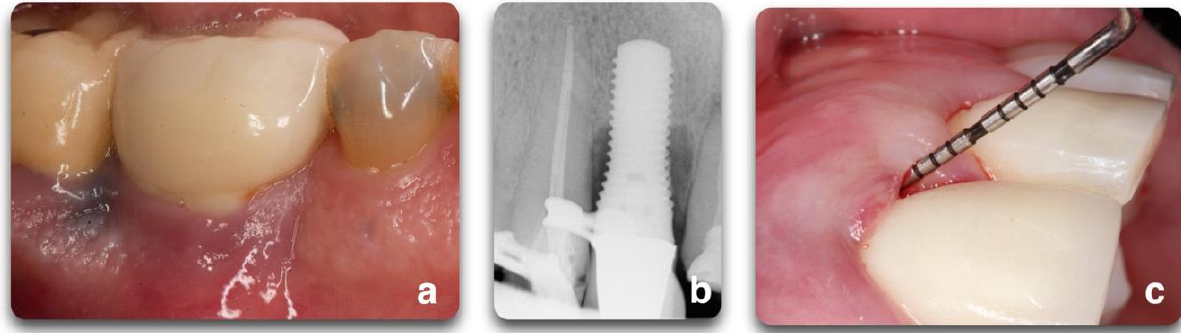
Figure 1. Representation of peri-implant clinical parameters that, associated, can lead to a diagnosis of peri-implantitis. In the sequence above, BOP/Suppuration ( a ), radiographic bone level ≥ 3 mm ( b ) in combination with PD ≥ 6 mm ( c ).